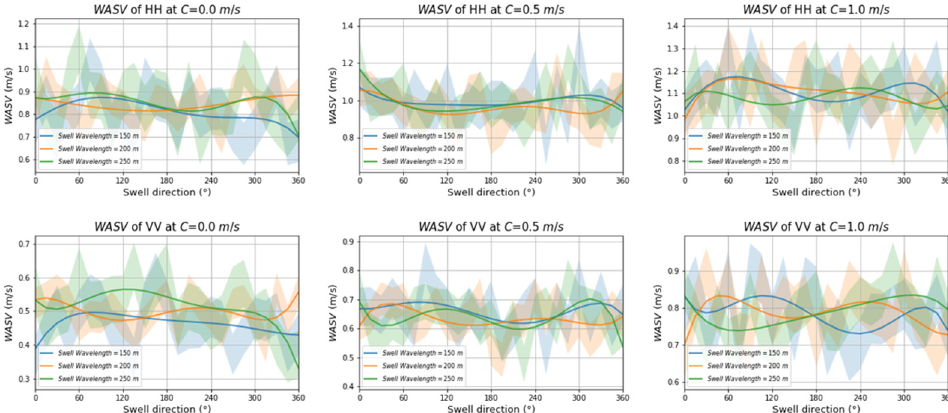
Figure 13. The relationship between WASV and swell direction for HH and VV polarizations and for different current velocities and swell wavelengths. Wind direction and speed were 0° and 10 m/s, respectively. Swell wavelength was 0.5 m. Other input parameters were set to the values indicated in Table 1. The swell wavelength is indicated by color: blue indicates wavelength of 150 m, yellow indicates wavelength of 200 m, and green indicates wavelength of 250 m. Solid line indicates mean values. Shaded areas indicate ±1 standard deviation of the median.